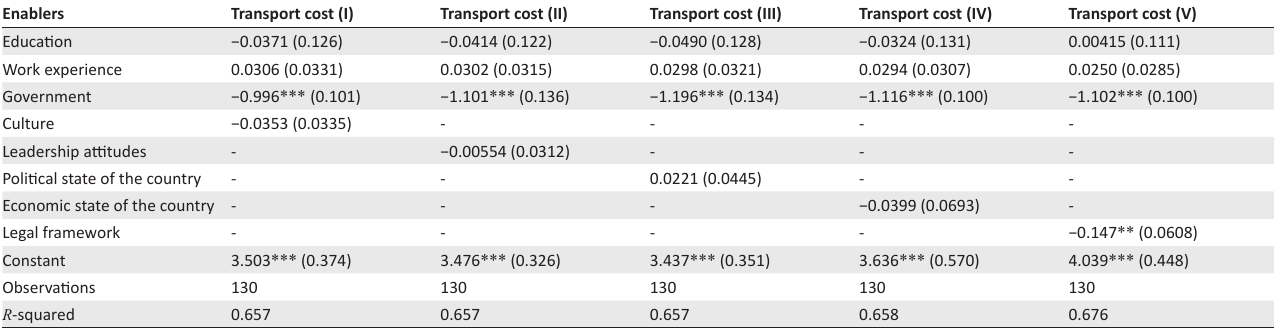
TABLE 4: The impact of enablers on transport cost.